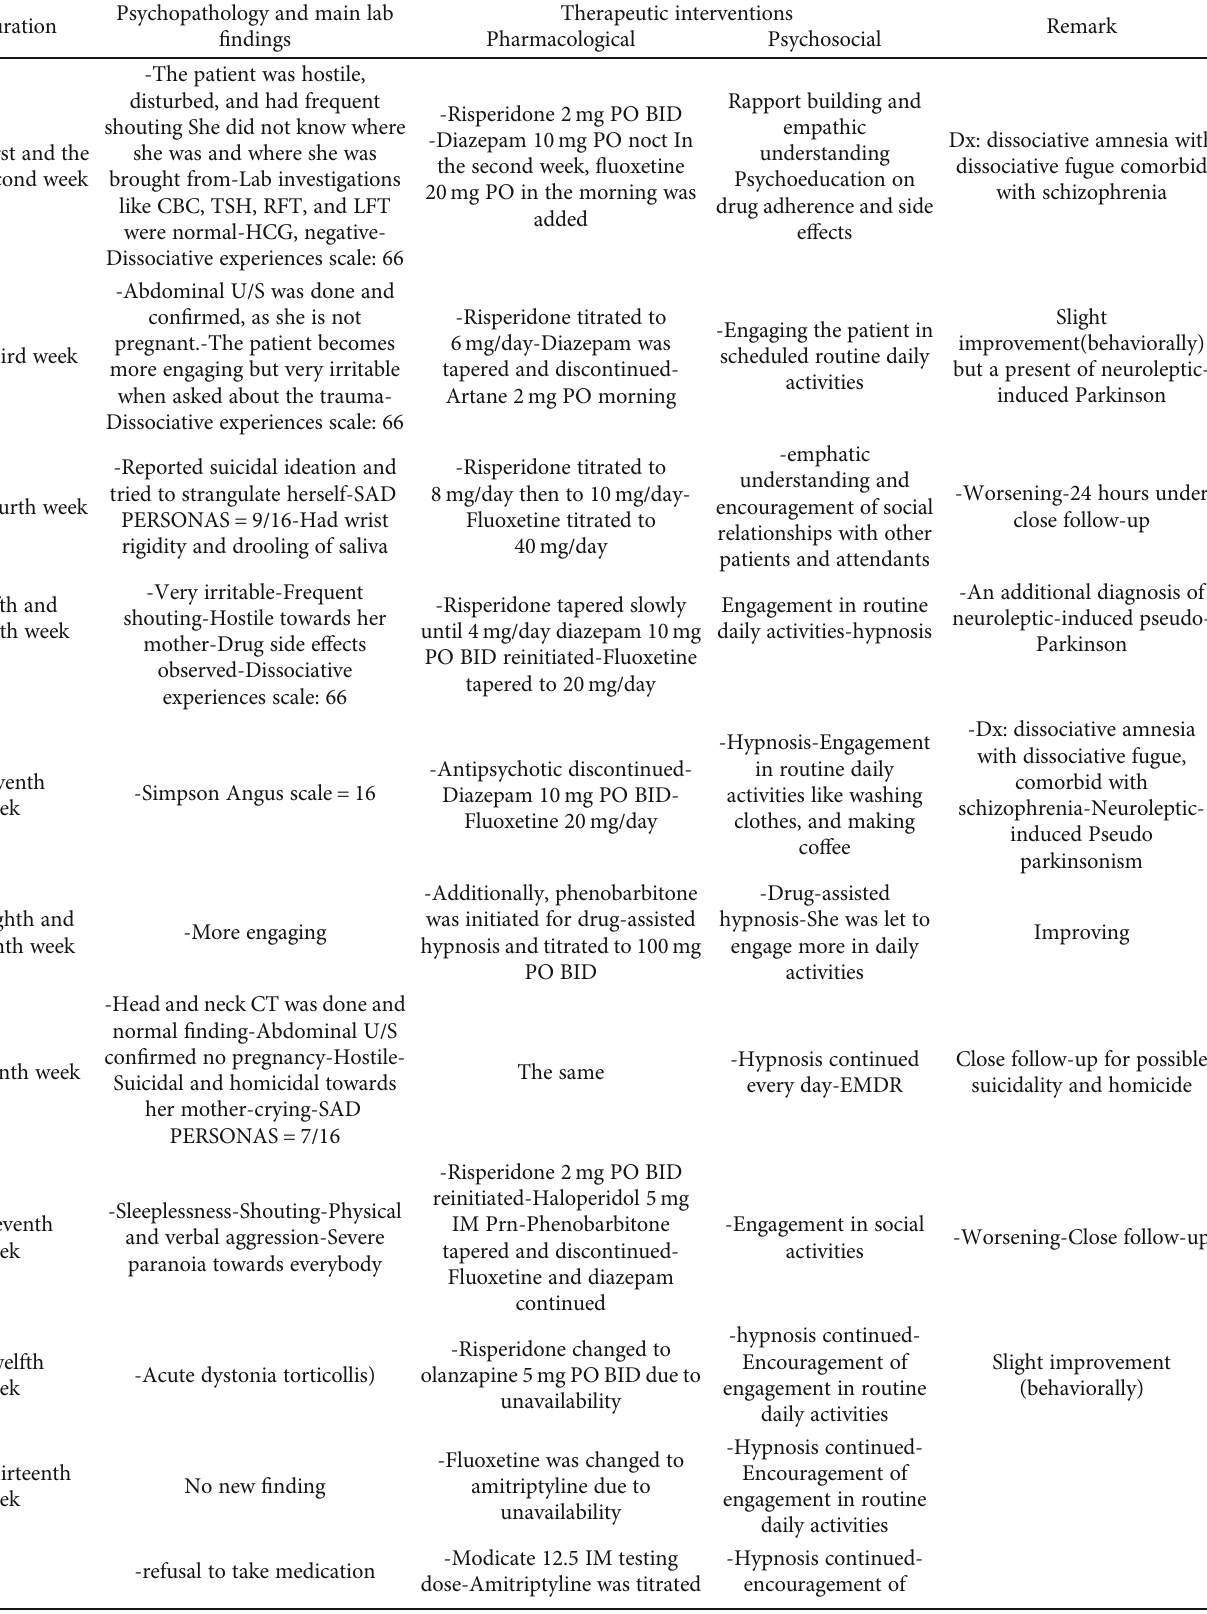
Table 1: Summary of the patient ’ s progress in the inpatient